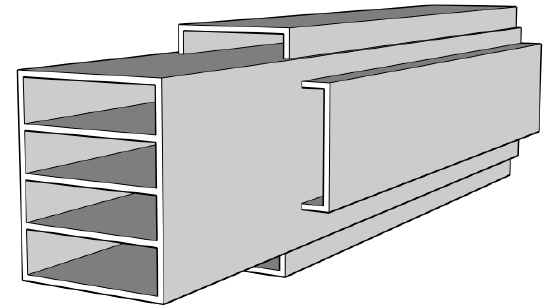
Figure 12. An example of a body whose volume represents the sawdust volume when sawing logs.